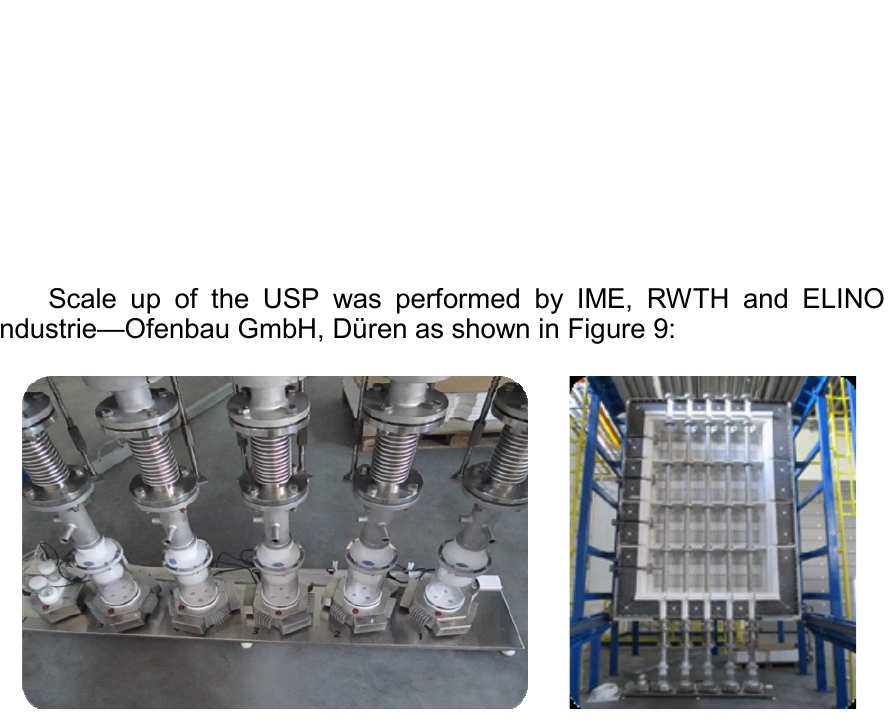
Fig. 9 – USP-generators & wall heated reactors/Scale up of the USP- process (Matula, et al, 2013,